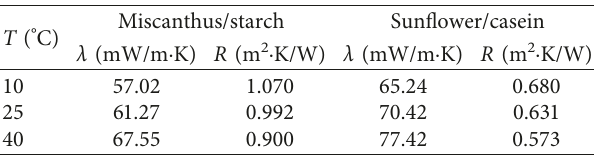
Table 1: Thermal conductivity λ and thermal resistance R according to temperature T for composites panels with 20% binder content. T ( °